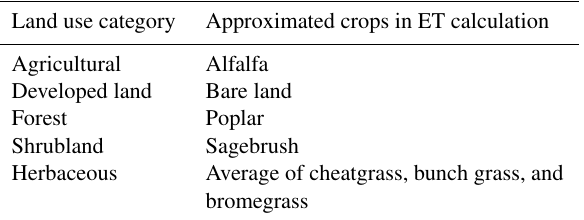
Table 2. Crop categories used to approximate the land use cate- gories in the ET